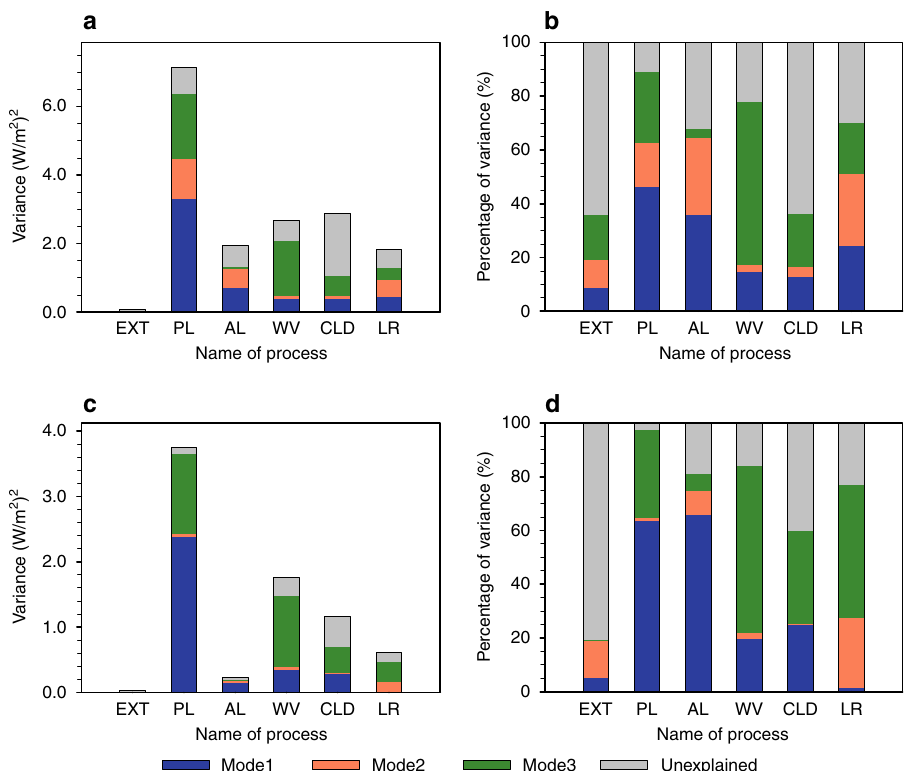
Fig. 6 Variance of partial radiative perturbations (PRP) at the top of the atmosphere (TOA) explained by the three dominant modes. a The variance (in units of (W/m 2 ) 2 ) of the zonal mean fi elds of inter-model spreads of PRPs at TOA. The color portions of each bar represent the variance explained by the fi rst three EOFs (Empirical Orthogonal Function), while the gray portion is the remaining variance. b The percentage (%) of the variance explained by the fi rst three EOF modes (colors) and the remaining unexplained percentage by the three modes is in gray. c , d Same as a and b but for the variance of their global means. The labels on the bottom of each panel stand for external forcing (EXT), Planck feedback (PL), surface albedo feedback (AL), water vapor feedback (WV), cloud feedback (CLD), and lapse-rate feedback